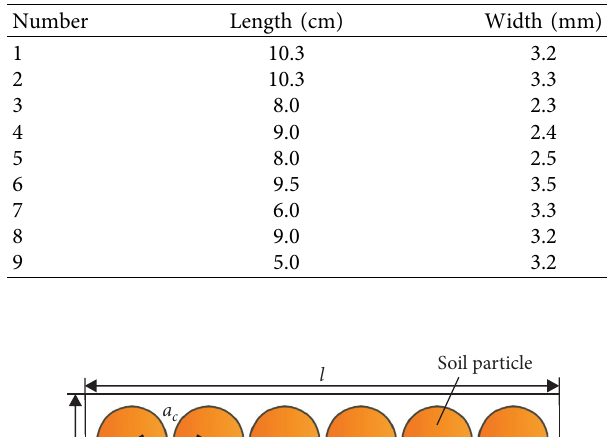
Table 2: The vertical joints in the model experiment.